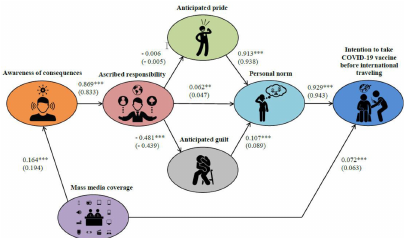
Figure 2. Results of the structural model estimation (n = 1221). Note. Goodness-of-fit indices: χ 2 (141) = 888.142, p < 0.001, RMSEA = 0.066 [0.062, 0.070], CFI = 0.965, TLI = 0.958, SRMR = 0.084. ** p < 0.01, *** p <